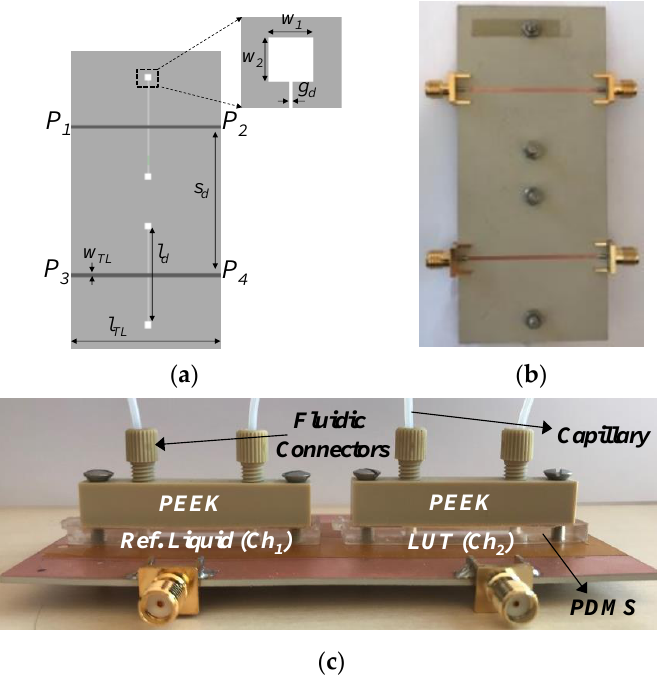
Figure 29. Layout ( a ) and photograph (top view ( b ) and 3D view ( c )) of the DB-DGS-based sensor. From [64], reprinted with permission.